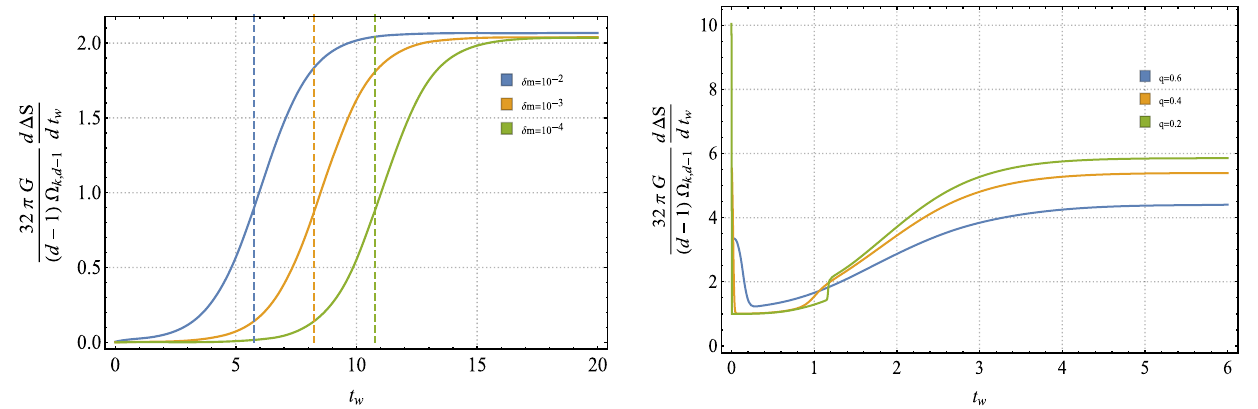
Fig. 3 The derivative of the complexity of formation with respect to t w . The left panel illustrates the behaviour for a light shock wave, with d = 3 , k = 0 , l ct = 1 , L = 1 , q = 0 . 6 ,ω 1 = 1, where the